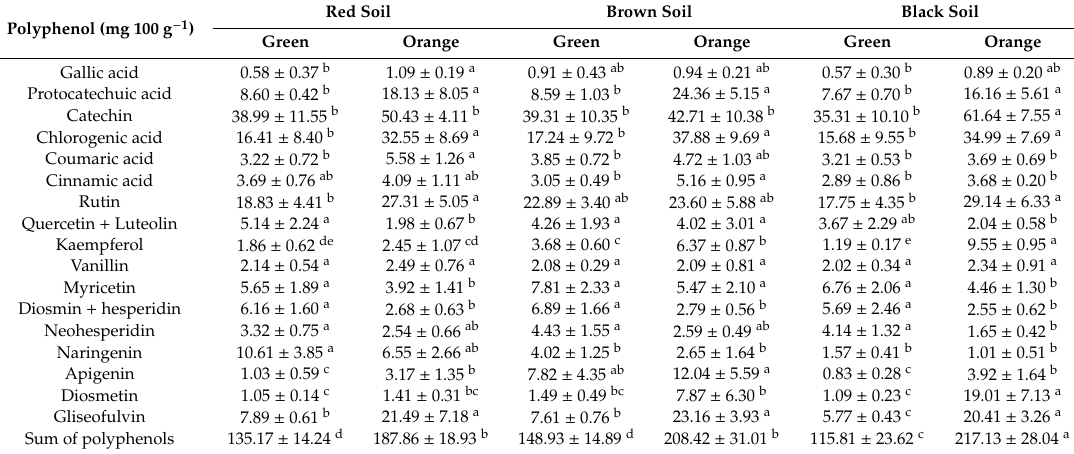
Table 2. Results of the quantification of polyphenols in mature (orange) and immature (green) habanero pepper ( Capsicum chinense Jacq.) cultivated in di ff erent